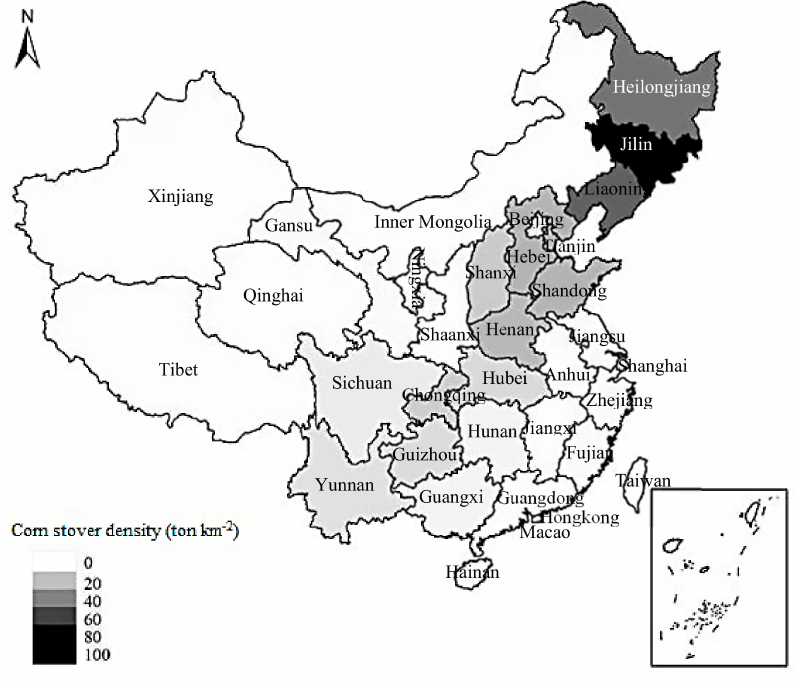
Figure 2. Geographical distribution densities of the available corn stover for ethanol production in di ff erent provincial regions in China in